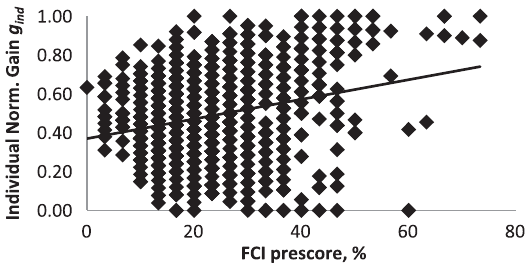
FIG. 6. Individual data for 803 students at Arizona School for the Arts, 2007 – 2018 ( r ¼ 0 . 25 ).